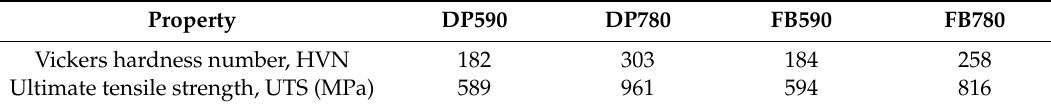
Table 3. Hardness measurement and predicted tensile strength of di ff erent